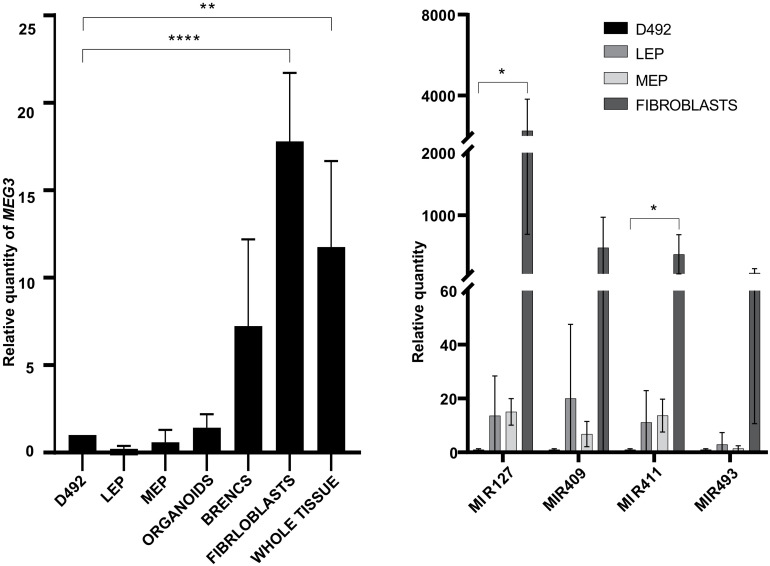
The ncRNA from the DLK1-DIO3 locus are highly expressed in stromal cells and whole tissue compared to epithelial cells. qRT-PCR showing MEG3 expression is higher in breast stromal cells (fibroblasts) and whole tissue than in D492 (left). (LEP – luminal epithelial cells, MEP – myoepithelial cells, BRENCs – breast endothelial cells). Results shown as mean ± SD. One-way ANOVA with Dunnett’s multiple comparisons test was used to test significance: **p ≤ 0.01; ****p ≤ 0.0001; n = 3. Expression of representative miRNAs MIR127 and MIR411 at the DLK1-DIO3 locus is higher in breast fibroblast than in D492 (right). LEP – luminal epithelial cells, MEP - myoepithelial cells. Results shown as mean ± SD. One-way ANOVA with Dunnett’s multiple comparisons test was used to test significance: *p ≤ 0.5; n = 3.